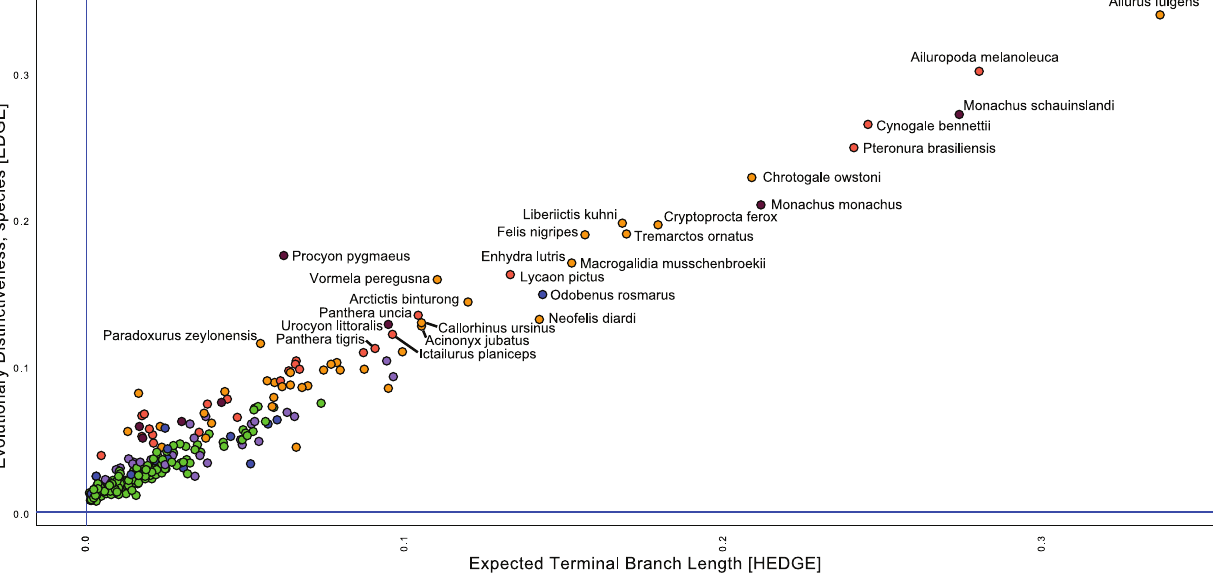
Figure 2. Conservation priorities based on the agreement between EDGE and HEDGE for Carnivora using the pessimistic transformation. (Red dots=Critically Endangered, Orange dots=Endangered, Yellow dots=Vulnerable, Dark Green dots=Least Concern, Light Green=Near Threat, Blue=Data Deficient).